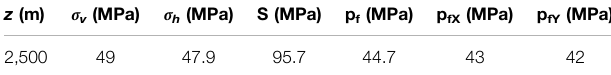
TABLE 1 | Far- fi eld stresses, pore pressures of the Valhall fi